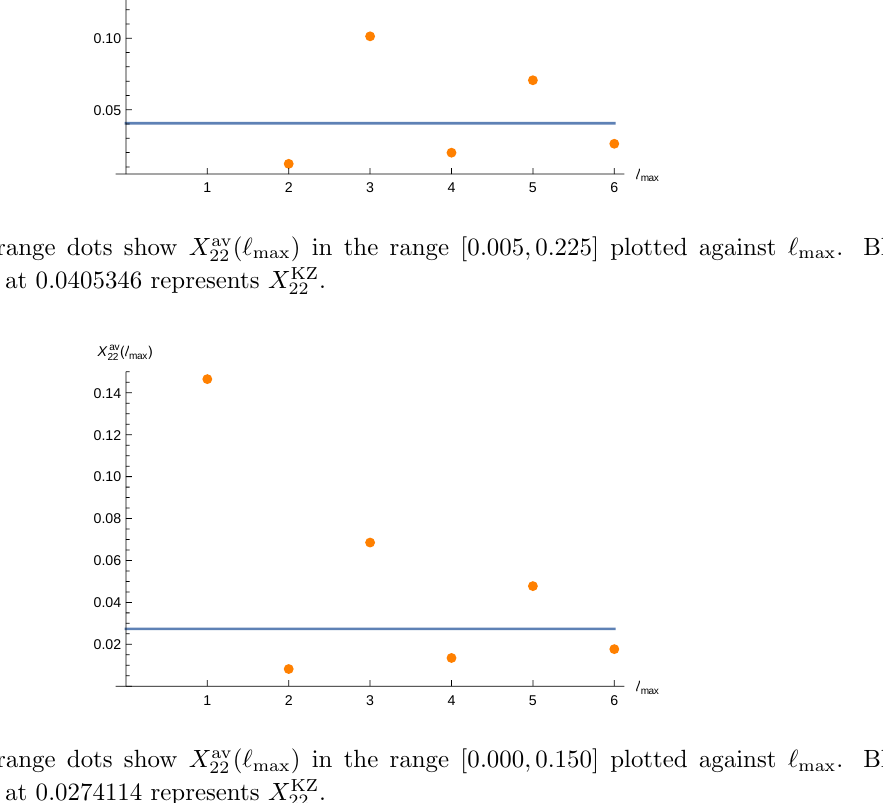
( ‘ max ) in the range [0 : 000 ; 0 : 150] plotted against ‘ max . Blue 22 22